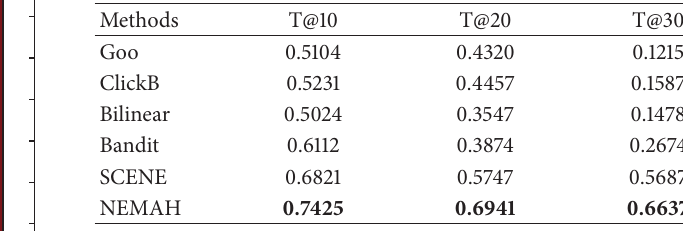
Table 3: Diversity evaluation on different recommendation